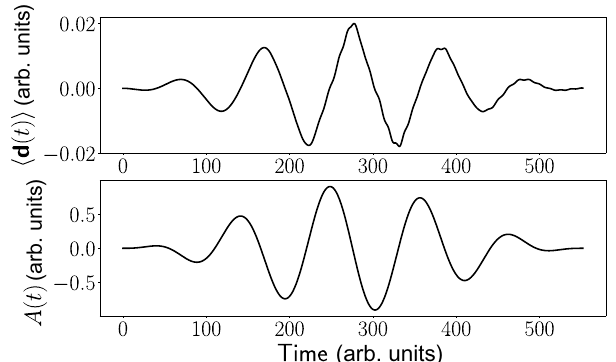
FIG. 18. (a) Dipole moment expectation value obtained from the numerical calculations under the SFA approach. (b) Vector potential used to obtain the dipole moment shown in (a). The pulse shown has n cyc = 5 cycles.